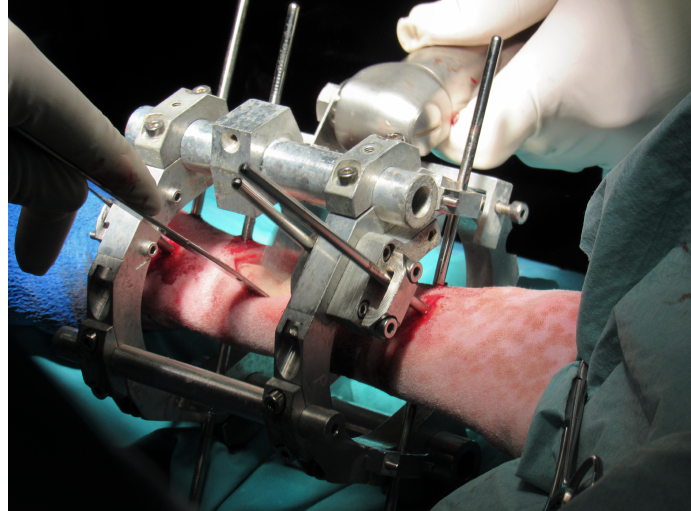
Figure 10. Implantation of the designed external fixator with non-instrumented bars into the sheep metatarsus and performance of the osteotomy, which divides the metatarsus into two bony fragments.